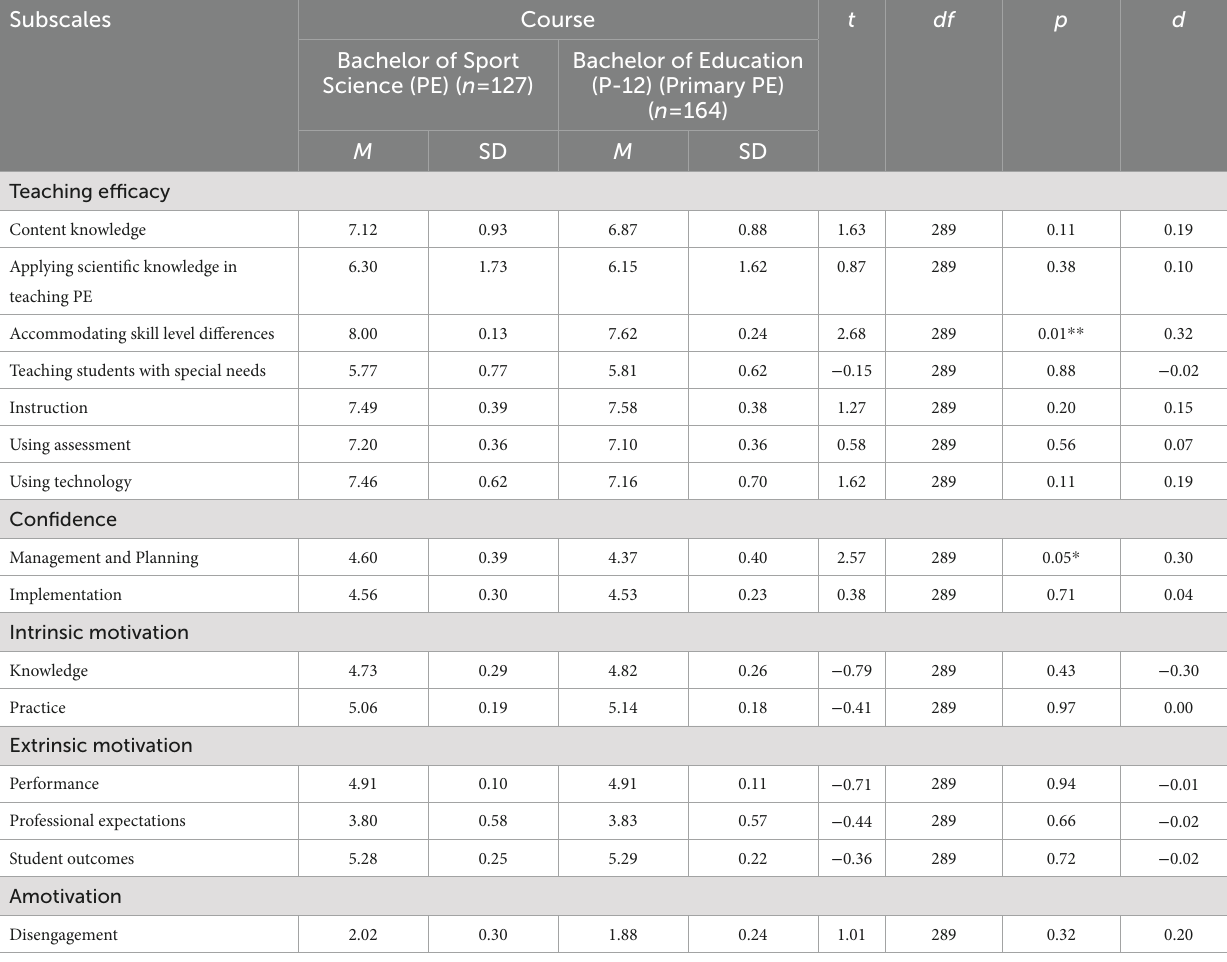
TABLE 5 Descriptive statistics and t -test results for teaching efficacy, confidence, and motivation subscales by course.